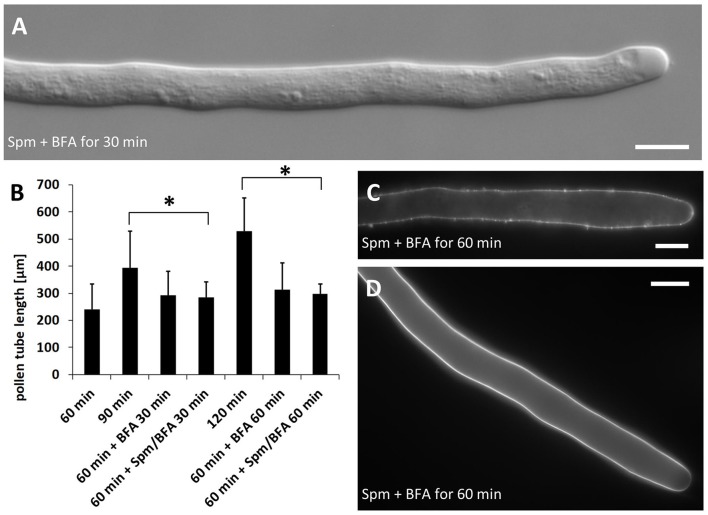
Effects of treatment with Brefeldin A (BFA) and Spm on pear pollen tube length and cell wall components. (A) A DIC view of 30 min-treated pollen tubes showing no defects in tube morphology. (B) Growth rates of control pollen tubes and of either BFA- or Spm+BFA-treated pollen tubes. The 60-min stage (first bar on the left) represents pollen tube growth before addition of chemicals. Pollen tubes were supplemented with BFA or Spm+BFA for an extra 30–60 min or they were grown under control conditions. The asterisk indicates that the measurements within square brackets are significantly different; in particular, data of treated pollen tubes are always significantly different compared to controls immediately to the left. Statistical analysis was performed using one-way ANOVA. (C) Labeling of pectins by PI. Pectins appear uniformly distributed. (D) Staining of callose by aniline blue. Callose is distributed as in controls and is absent in the very tip region. Bars: 10 μm.